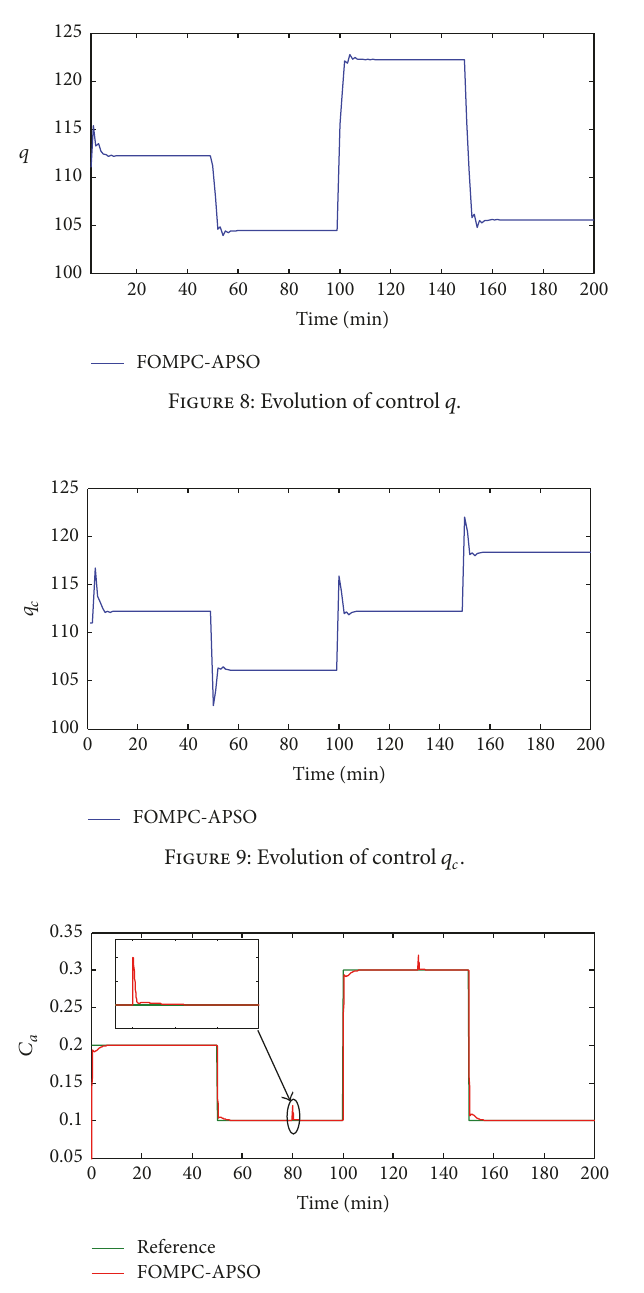
Figure 10: Evolution of concentration with external